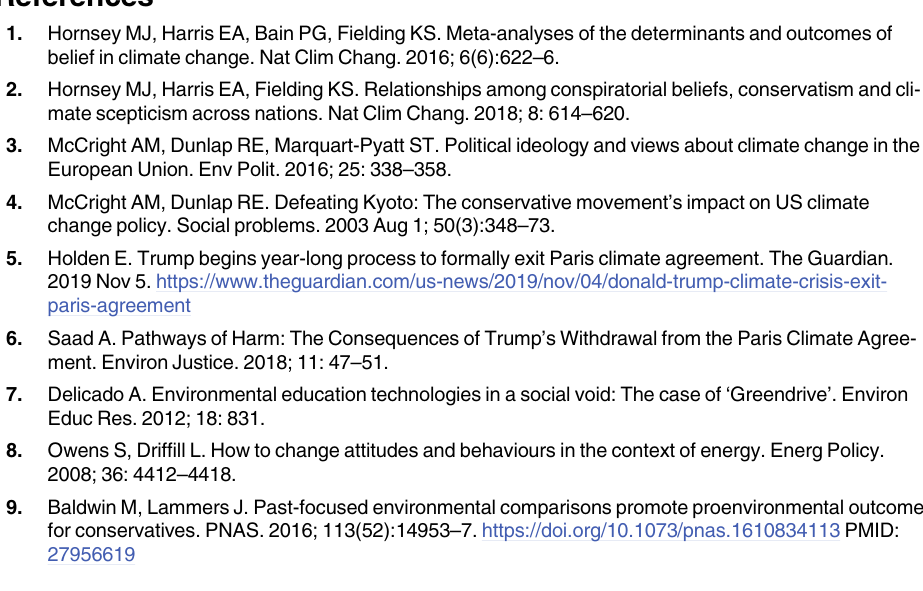
S11 Table. Standardized regression coefficients regressing each DV on the dimensions of SDO and